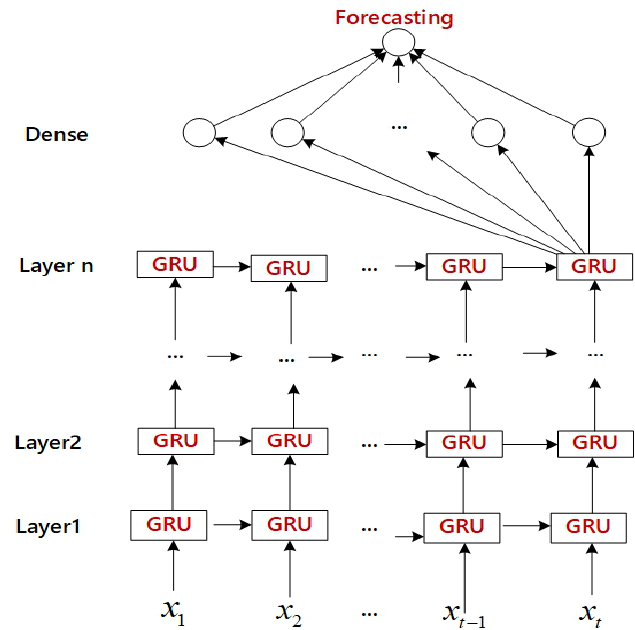
Figure 4. Architecture and workflow of ML-GRU.